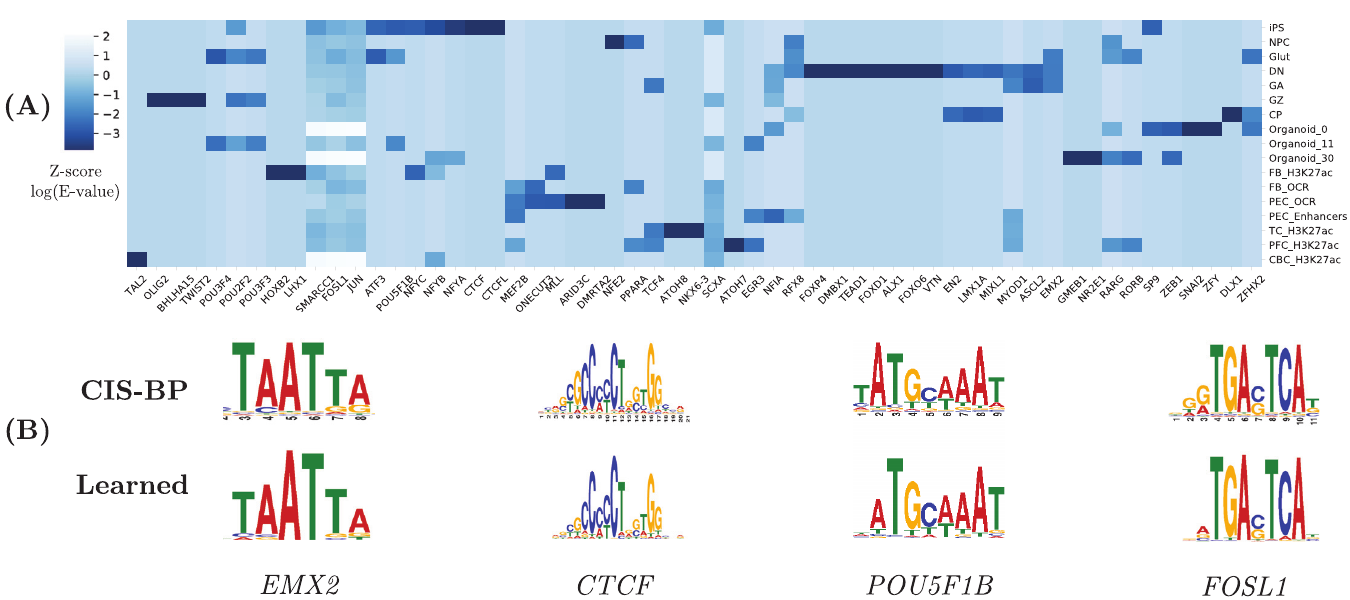
Fig 7. (A)Distribution of matched motifs in each epigenomic assay and (B)selected binding motifs identified by our method and their matches in the CIS-BP